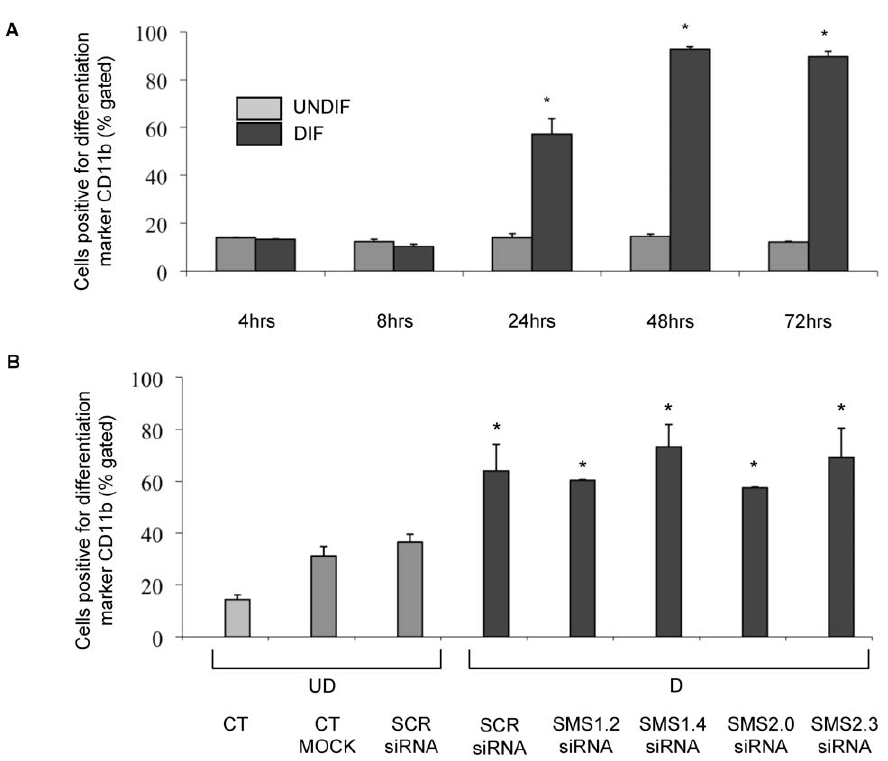
Figure 3. Analysis of CD11b differentiation marker by flow cytometry. ( A ) HL-60 cells were plated at 1 6 10 5 cells/mL and differentiation induced. Undifferentiated cells received vehicle solution for the retinoic acid. Differentiated and undifferentiated cells were collected at the indicated time points and processed for flow cytometric analysis of CD11b positive cells. * P , 0.05 compared with undifferentiated time-matched samples. ( B ) Effect of modulation of either SMS1 or SMS2 on differentiation of HL-60 cells by analysis of CD11b differentiation marker using flow cytometry. Two million HL-60 cells were transfected with 4.5 m g of SCR siRNA, SMS1 siRNA (1.2 and 1.4), and SMS2 siRNA (2.0, 2.3) by nucleofection. Downregulation and differentiation proceeded for 48 hours. Cells were then collected and processed for flow cytometric analysis of CD11b. * P , 0.05 compared with SCR siRNA undifferentiated cells. UD: undifferentiated cells; D: differentiated cells; CT MOCK: control for transfection reagent; SCR: control scrambled siRNA.